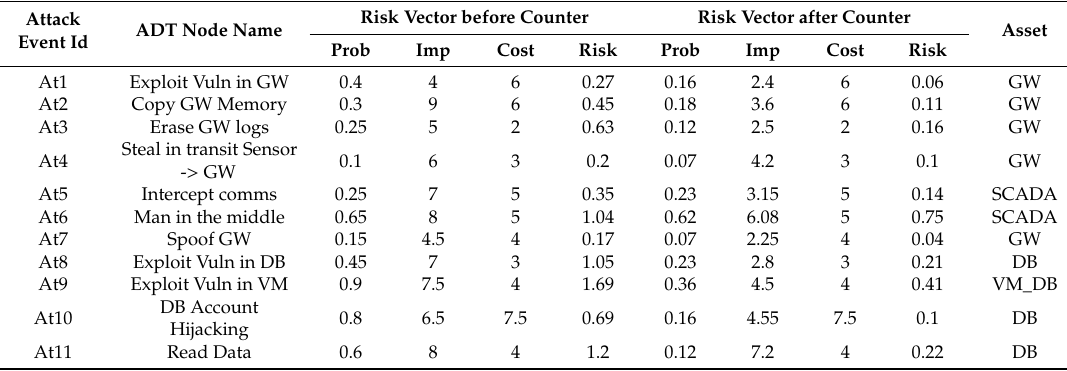
Table 4. Risk vectors for attack event nodes (before and after countermeasures) in the steal energy data ADT.